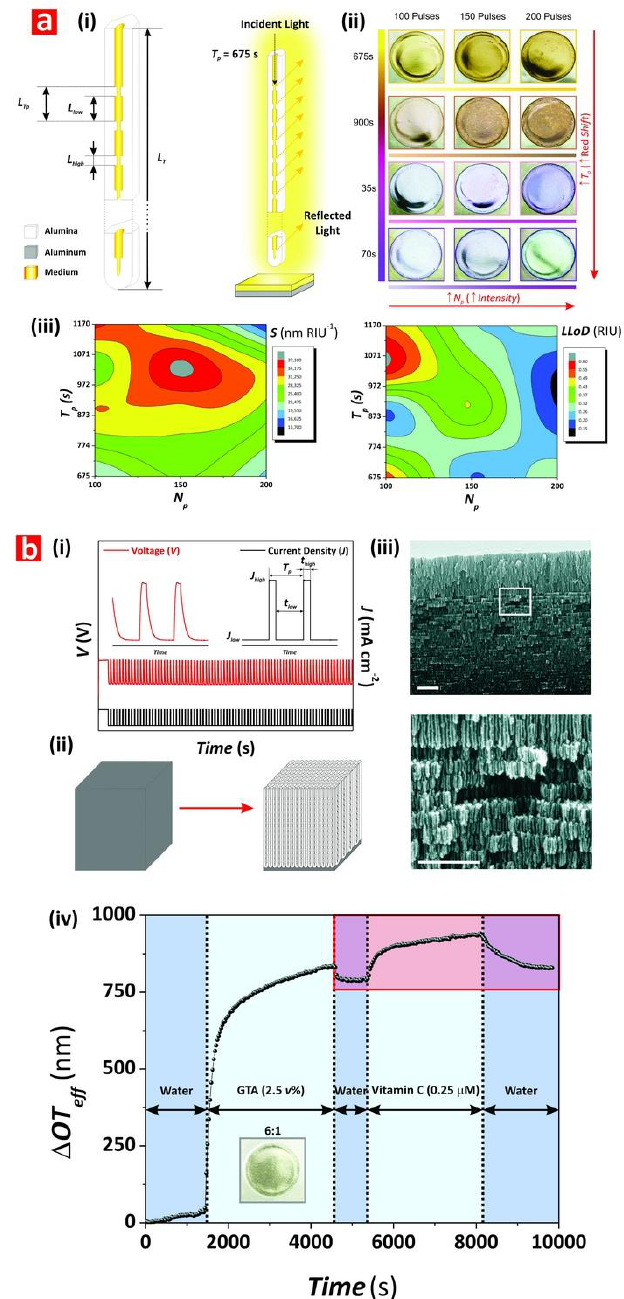
Figure 8. Examples of applicability of NAA-PCs in chemo- and biosensing applications. ( a ) ( i ) Schematic showing details of the structure of Nanoporous anodic alumina-distributed Bragg reflectors (NAA-DBRs) produced by STPA, ( ii ) digital pictures showing the interferometric colors displayed by these NAA-PCs, and ( iii ) sensitivity and low limit of detection as a function of the fabrication parameters. Reproduced from [231], with copyright permission from American Chemical Society, 2015. ( b ) ( i ) STPA profile used to produce NAA-DBRs, ( ii ) schematic showing the fabrication of NAA-DBRs by STPA, ( iii ) SEM images of NAA-DBRs, and ( iv ) real-time effective optical thickness change for each sensing stage of vitamin C. Reproduced from [232], with copyright permission from American Chemical Society, 2015. Different concentrations of vitamin C solutions were used to characterize the sensing performance of APTES-functionalized NAA-DBRs through real-time measurements of ∆ OT eff using RIfS. The performance of this sensing system for vitamin C was S = 227 nm µM −1 , LLoD = 20 nM, and